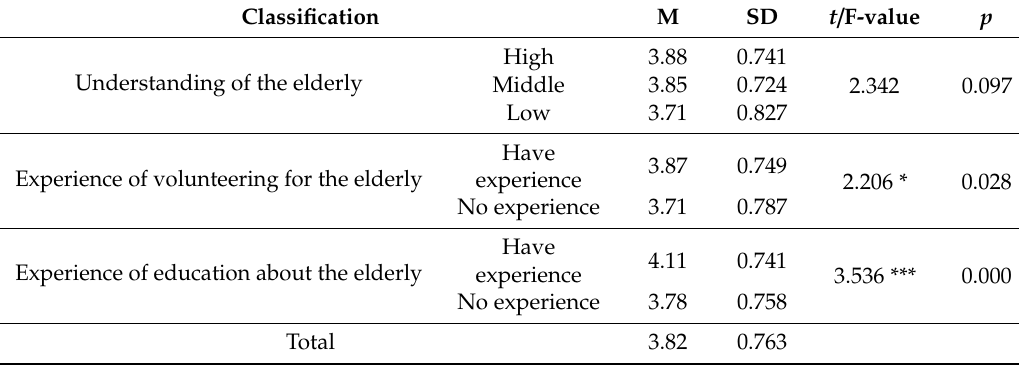
Table 3. Di ff erences in educational needs for senior beauty services.